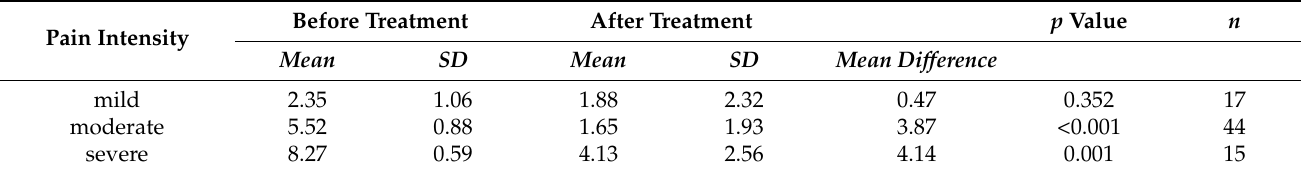
Table 4. The Visual Analogue Scale (VAS) change of the groups of different initial pain intensity.